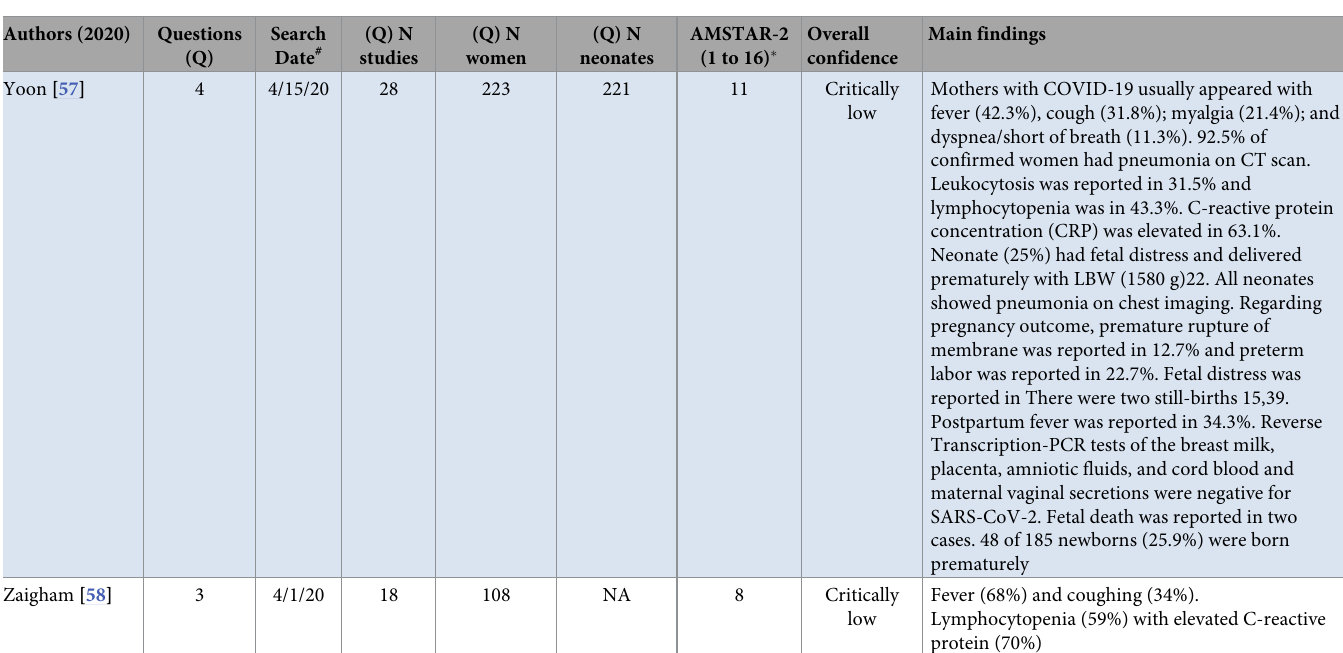
Table 3, Table 3 in S8 File . The most frequently reported outcomes were C-section and pre- term delivery.